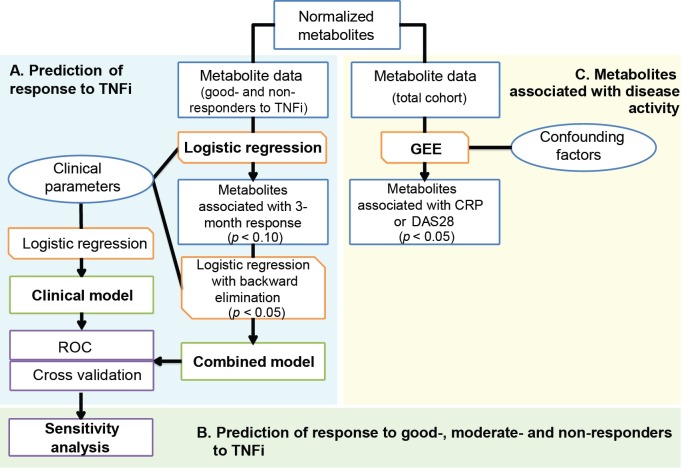
Flowchart of statistical analyses.(A) Prediction of response to TNFi: All steps to build a prediction model on TNFi response were performed on the TNFi subset with EULAR good-response or non-response (n = 124). (B) Sensitivity analysis on the complete cohort of TNFi initiating patients. (C) Metabolites associated with disease activity. Analyses to investigate metabolites association with CRP, ESR or DAS28 were performed on the total cohort of patients using bDMARDs (n = 231; including TNFi and non-TNFi treated patients). Blue boxes/circles indicate (selection of) respectively metabolites or clinical parameters, whereas orange boxes indicate the performed analyses. bDMARDs: biological disease-modifying anti-rheumatic drugs; CRP: C-reactive protein; DAS28: disease activity score based on a 28-joint count; ESR: erythrocyte sedimentation rate; GEE: generalized estimating equation, LC-MS: liquid chromatography coupled to mass spectrometry; ROC: receiver operating characteristic; TNFi: TNF-α inhibitor.